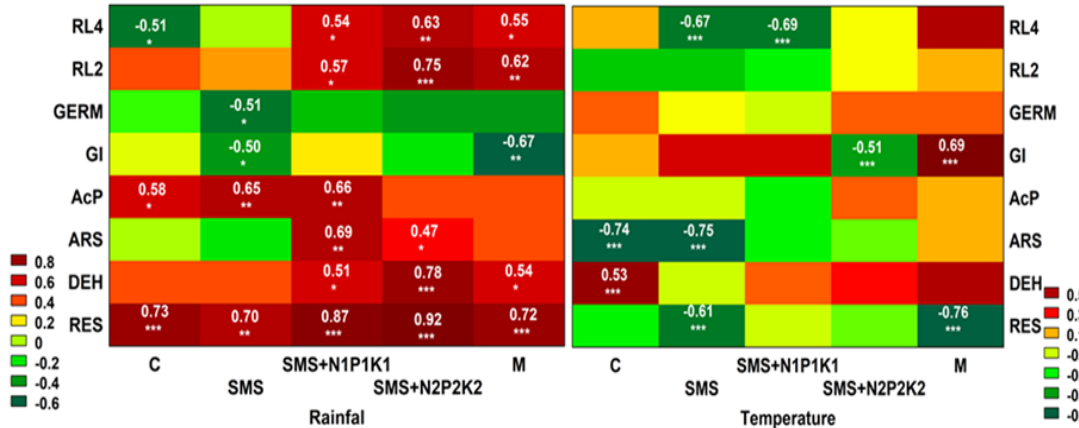
Figure 12. Heat map displaying the Pearson correlation coefficients between environmental factors (rainfall and temperature); biochemical and enzymatic activity; and phytotoxic parameters; as well as physicochemical and chemical properties at the combination level. Significance noted at * p < 0.05; ** p < 0.01; and *** p < 0.001, respectively. RL4 — root length of L. sativum after four days,